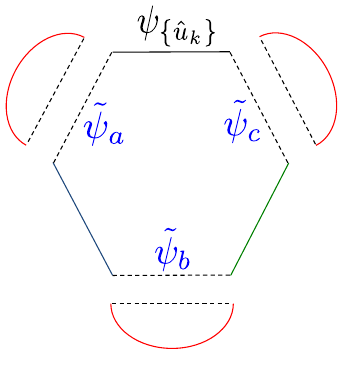
Figure 21 . Finite size correction to the non-BPS three-point function. The (cid:12)nite size correction comes from having nontrivial states on the edges glued to the boundary states. To compute it we need to consider the hexagon form factor depicted